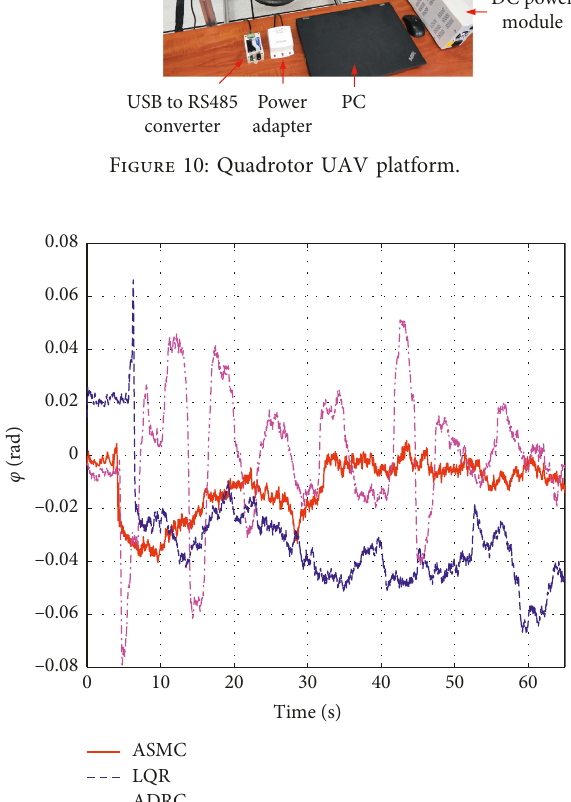
Figure 11: Tracking results of roll angle under the wind speed of 1.6